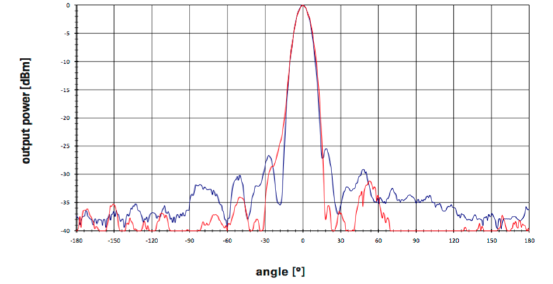
Figure 3. IVS-167 Antenna vertical (blue) and horizontal (red) pattern